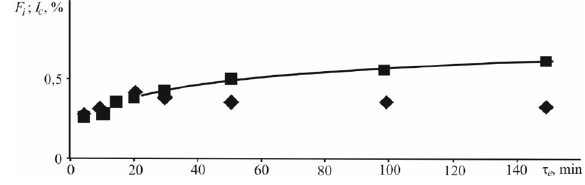
Figure 5. Change in blackness when changing the expo– sure time ( (cid:132) – index I c ; (cid:139) – flowing blackness of a point F i ) Determining the maximum possible resolution of the method is carried out, which allows for predicting the depth of layer damage by the detected defects.